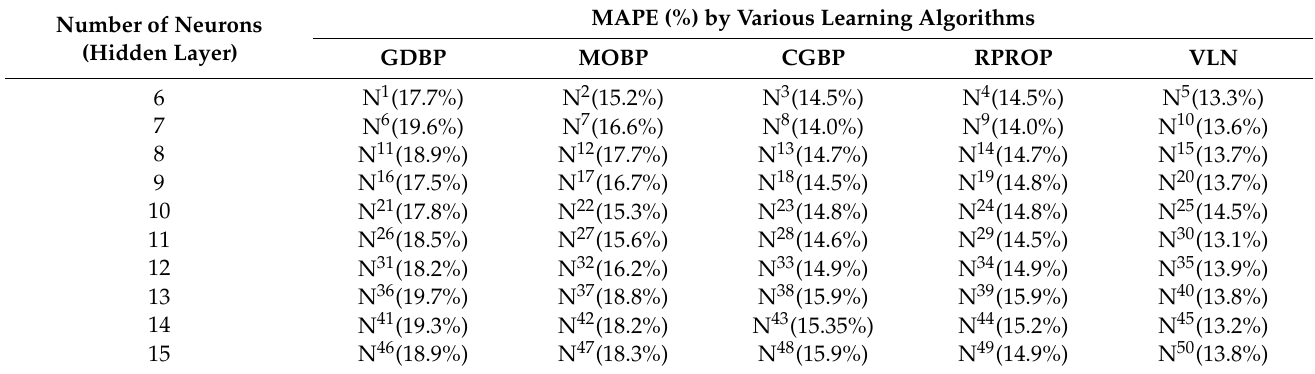
Table 4. The MAPE (%) results of the BP ANN model using different learning algorithms.